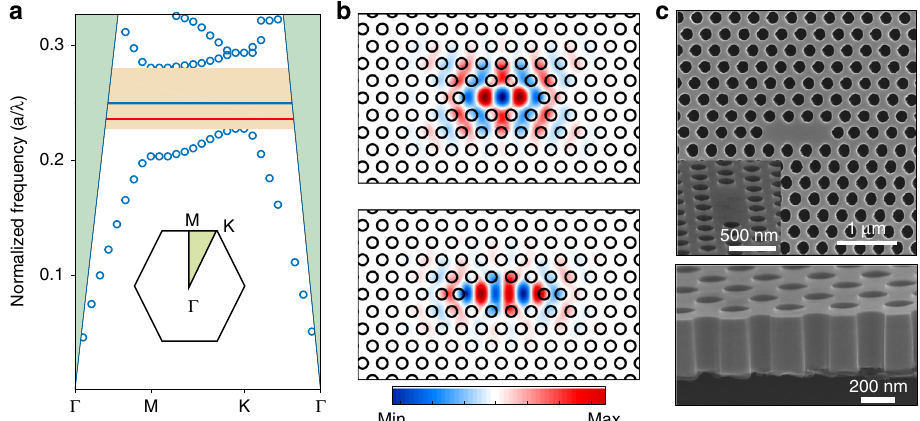
Fig. 2 3D-FDTD simulation and PC cavity. a Fundamental TE mode band diagram of the triangular lattice PC cavity with the irreducible Brillouin zone, calculated by using 3D-FDTD method. The shaded green region is the light cone and the yellow region indicates the photonic band gap. b The calculated E y fi eld pro fi les of the fundamental mode and the higher order mode of the PC cavity, of which the normalised frequencies are presented as the red and blue line in a . c Top-view and tilted cross-section view SEM images of the fabricated PC